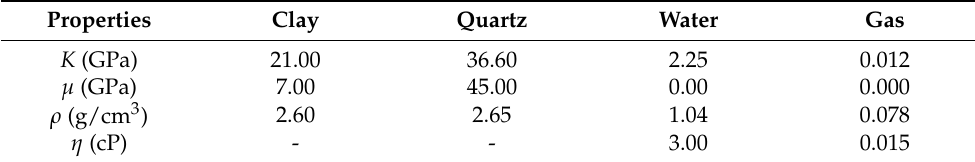
Table 1. Properties for rock physics modeling of tight sandstone [28,29].